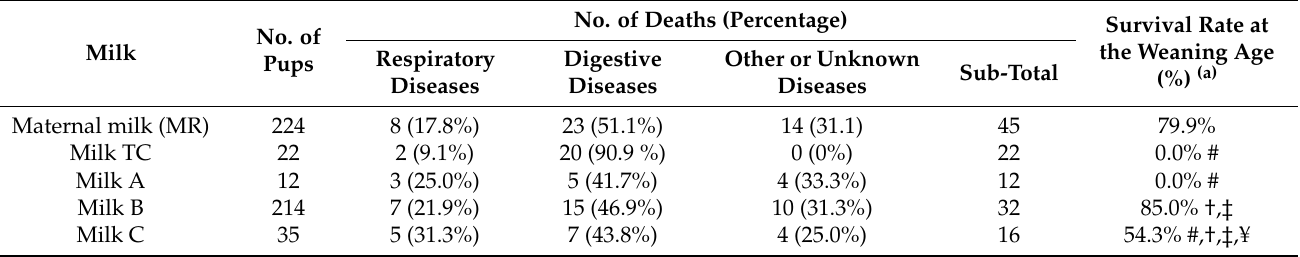
Table 3. Number of deaths before the weaning of tree shrew pups and survival rate at the weaning of pups fed with different